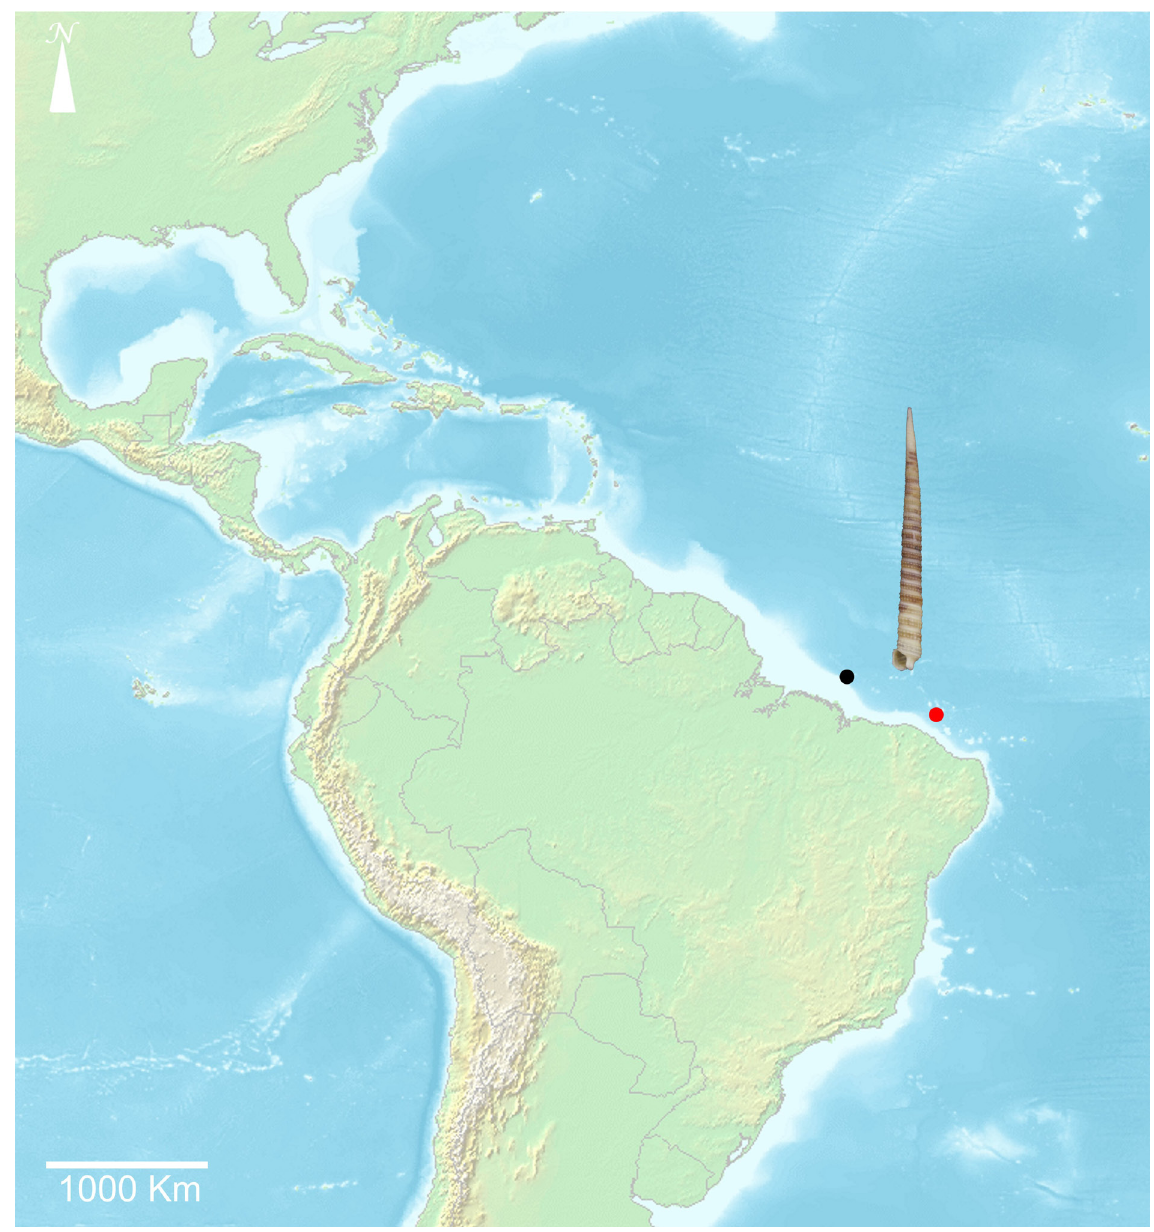
Fig. 72. Distribution map of Strobiligera unicornium (Simone, 2006); red circle = type